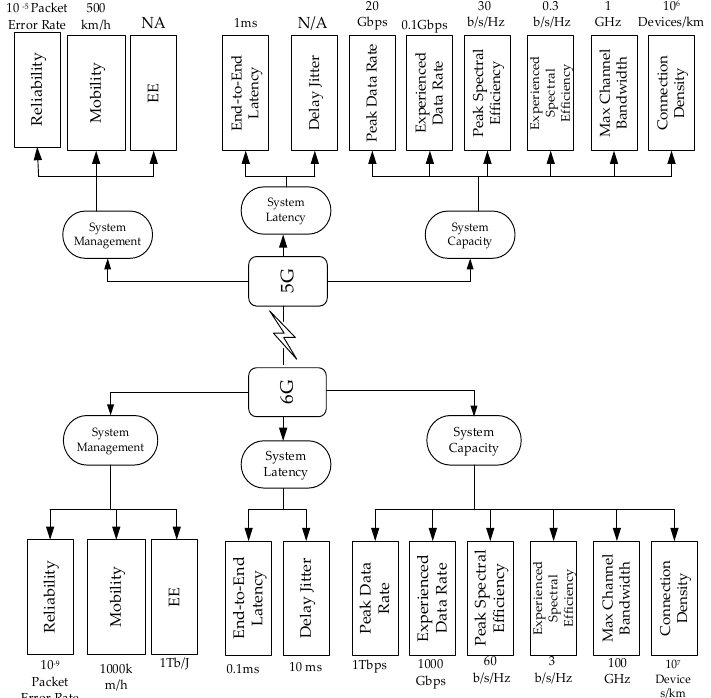
Figure 2. Comparative Analysis of 5G and 6G Key Performance Indicators.